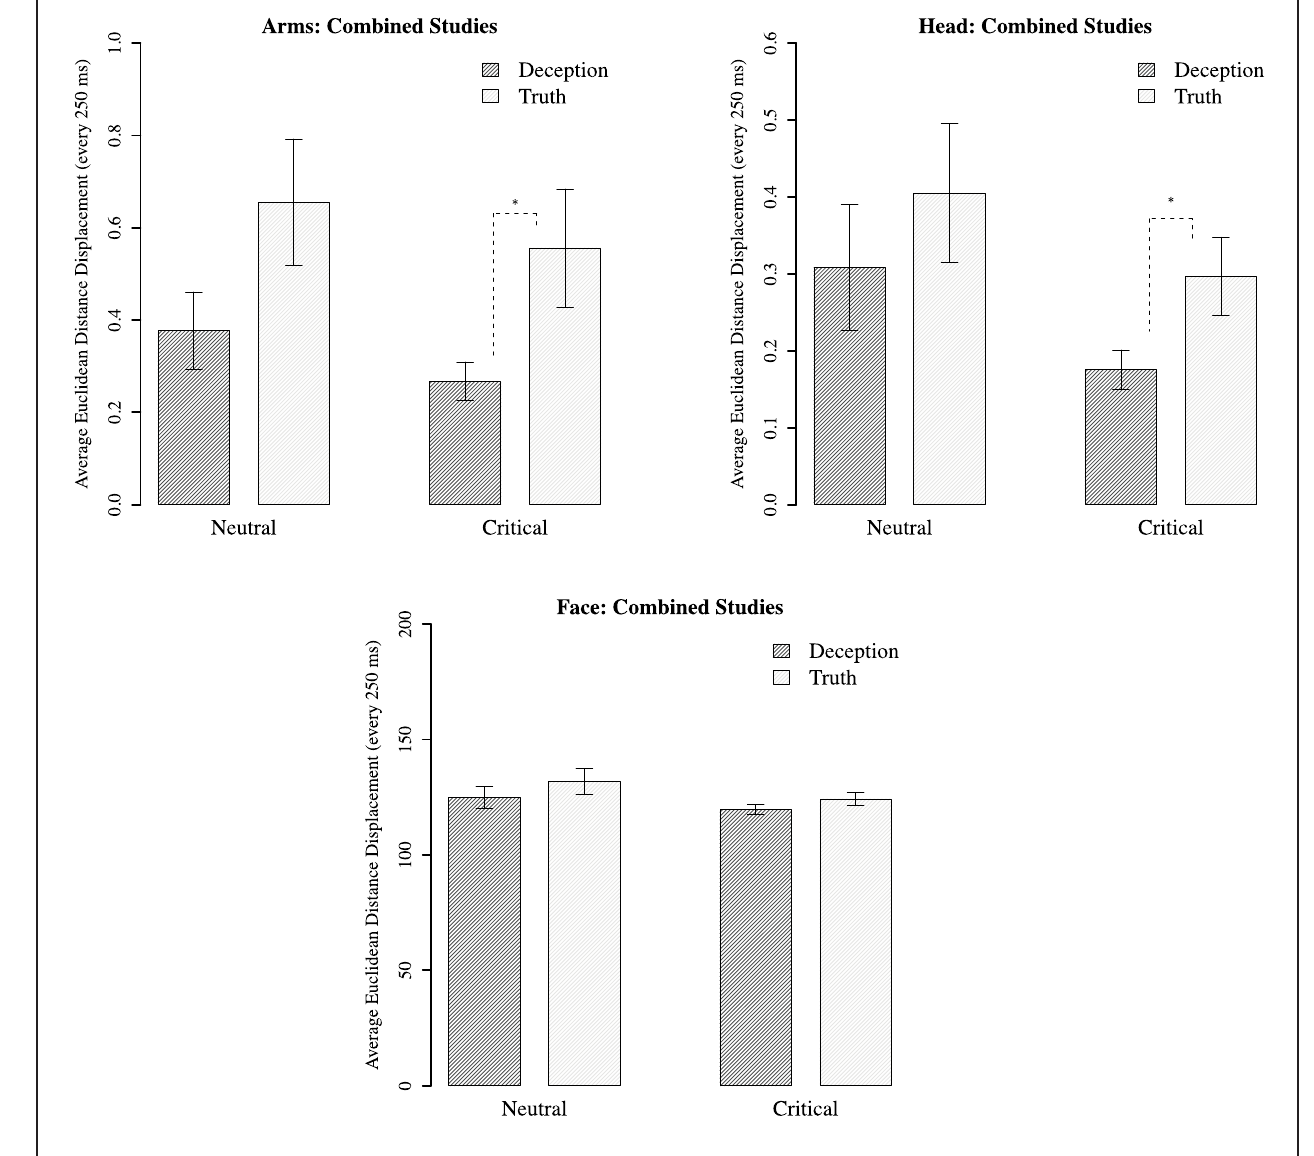
are participants who lied during the critical phase; white bars are those who told the truth. Bars are grouped according to